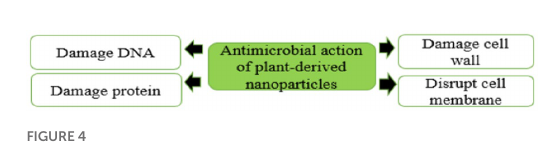
FIGURE 4 Antimicrobial action exhibited by plant-derived